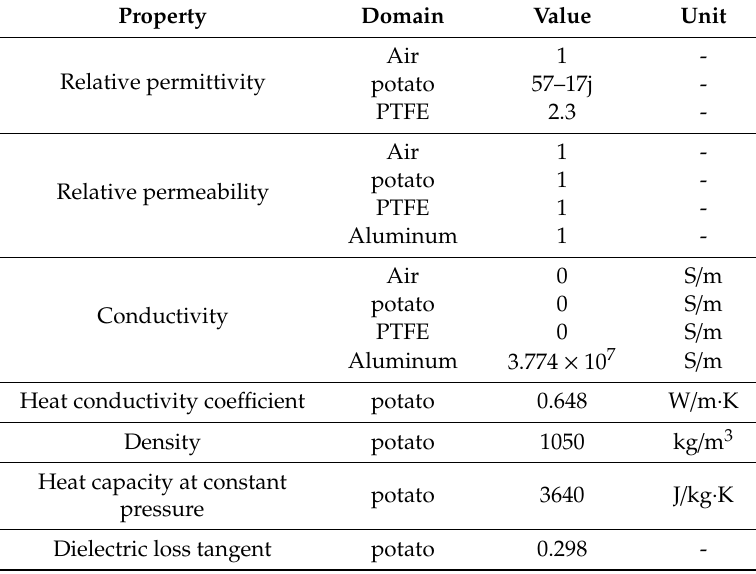
Table 1. Related input